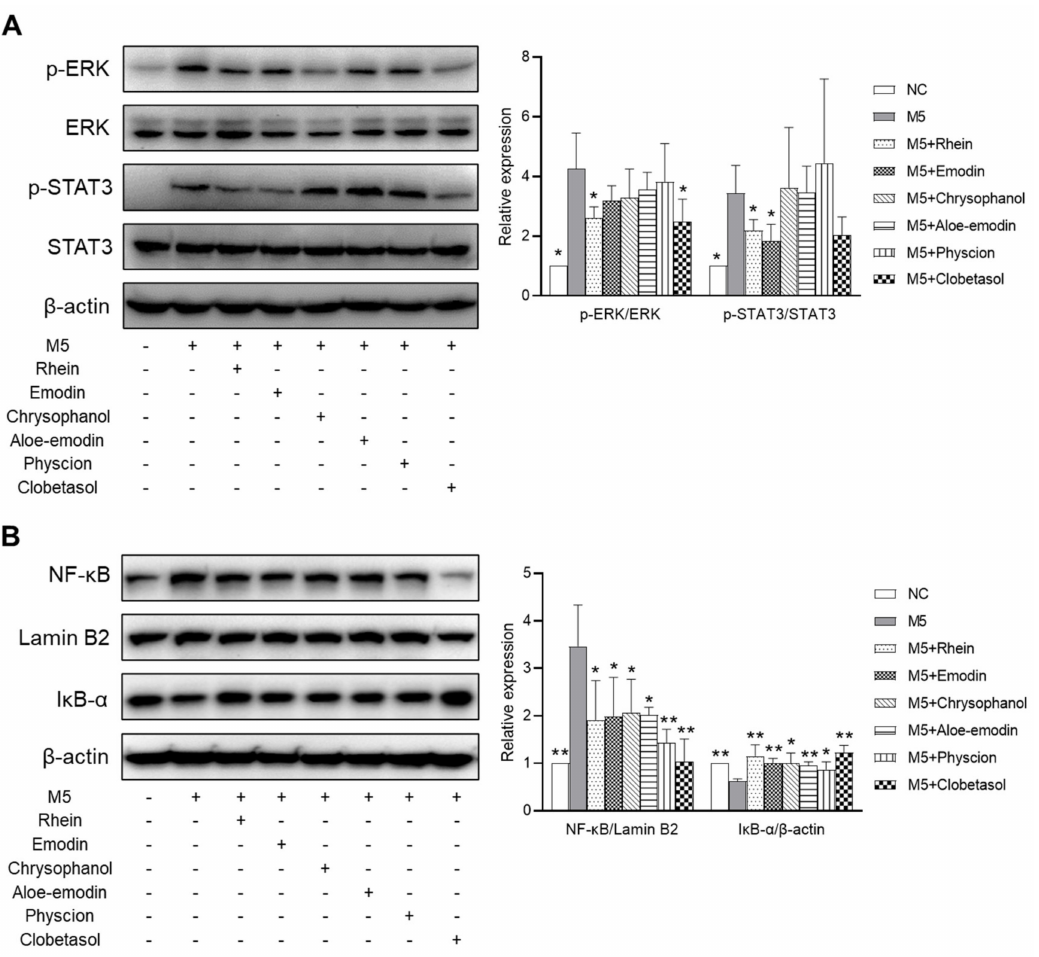
Figure 8. Effects of RPE compounds on ERK, STAT3, and NF- κ B pathways in M5-stimulated HaCaT cells. The cells were pretreated with RPE compounds (10 µ M) for 1 h and then stimulated with M5 for 30 min. ( A ) Proteins were analyzed by Western blot and the band intensities of p-ERK and p-STAT3 were normalized to ERK and STAT3, respectively. ( B ) Proteins were analyzed by Western blot and the band intensities of NF- κ B (nuclear fraction) and I κ B- α (cytoplasmic fraction) were normalized to lamin B2 and β -actin, respectively. Data are expressed as means ± SDs ( n = 3 per experiment). * p < 0.05, ** p < 0.01 vs. M5-treated cells. ERK: extracellular signal-regulated kinase, STAT3: signal transducer and activator of transcription 3, NF- κ B: nuclear factor kappa B, and I κ B- α